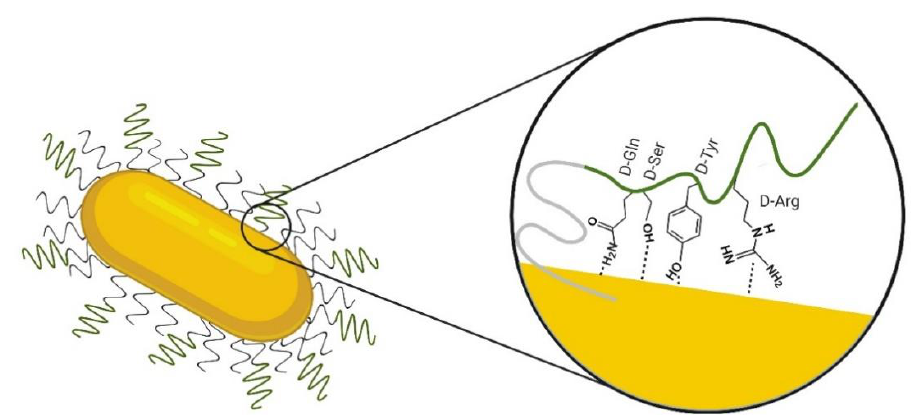
Figure 6. Scheme of the hypothesized orientation of D1(D-Gln-D-Ser-D-hys-D-Tyr-D-arg-D-hys-D- Ile-D-Ser-D-Pro-D-Ala-D-Asn-D-Val) on the GNR-PEG-D1 surface based on SERS results; D1 sequence is represented in a green line and polyethyleneglycol (PEG) in a gray line. Note that we intended to represent the approaching of the different residues to the gold surface. However, we cannot derive a conclusion about the secondary structure of the